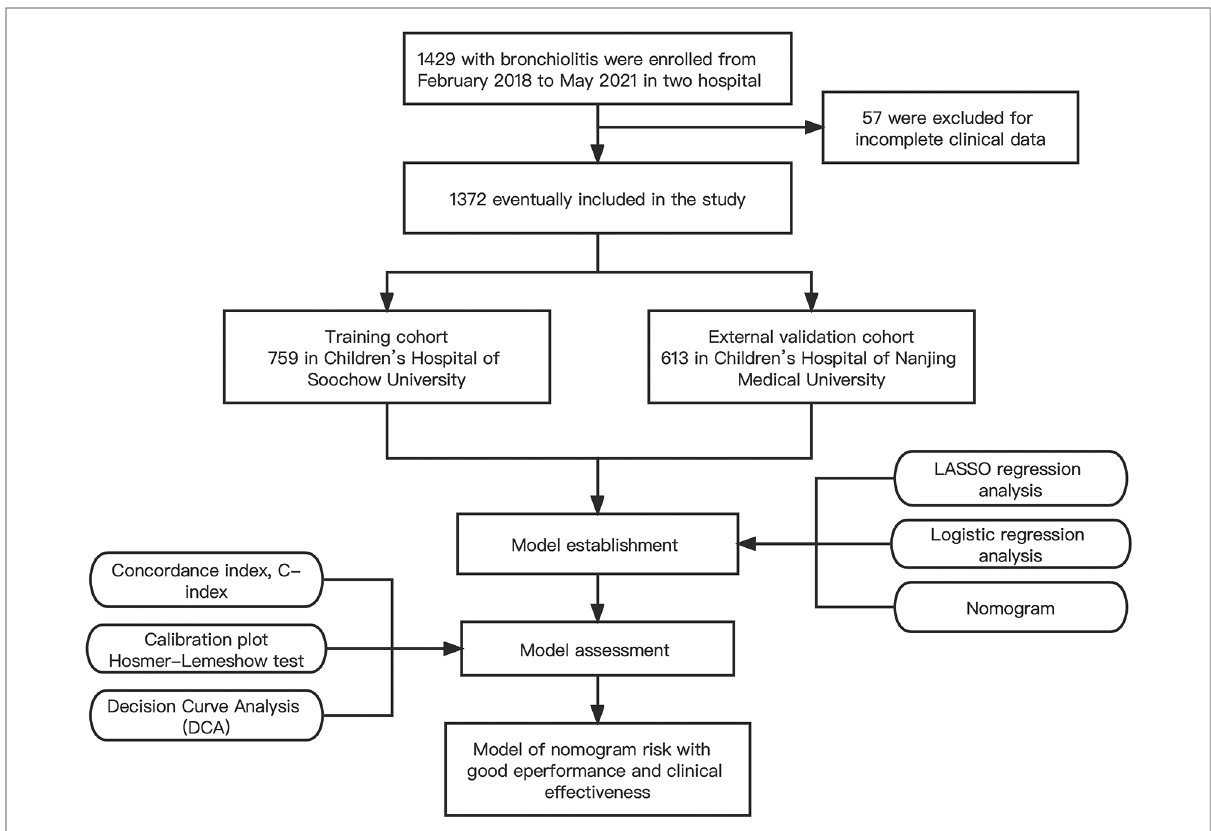
FIGURE 1 Flow diagram of study